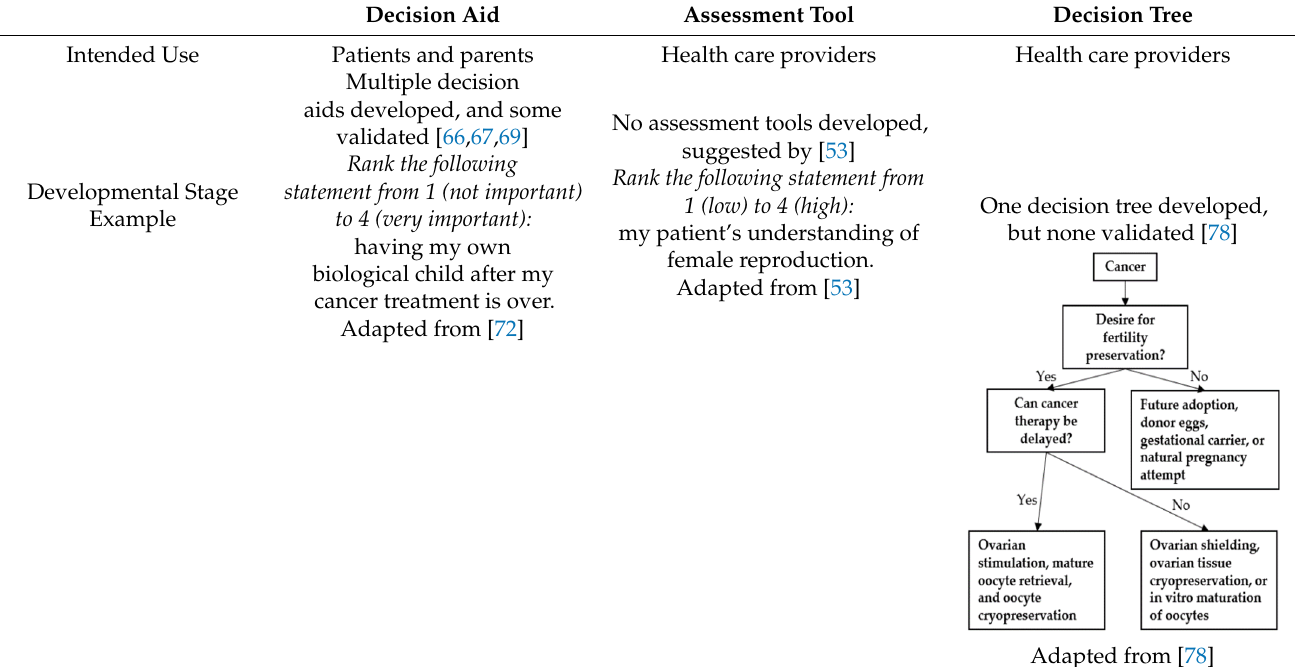
Table 1. Overview of oncofertility decision tools available to patients, parents, and health care providers. Assessment Tool Decision Tree